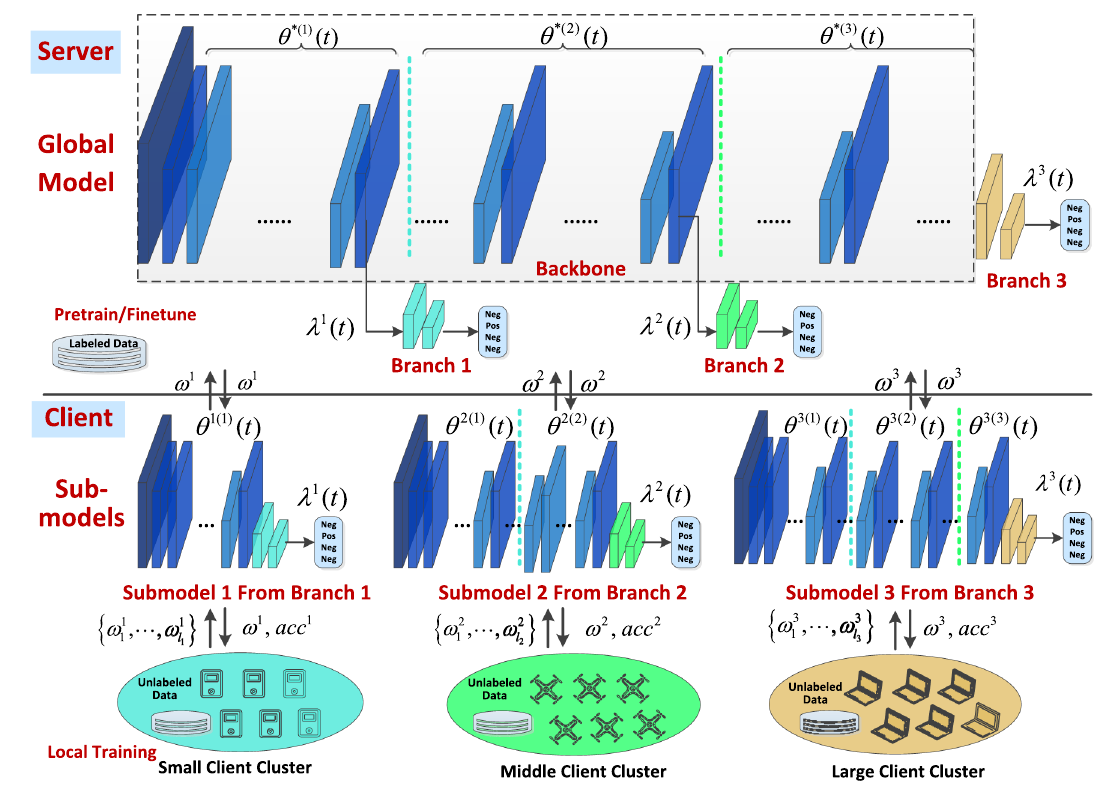
Fig. 2 The framework of Semi-HFL. Taking the number of branches n = 3 as an example